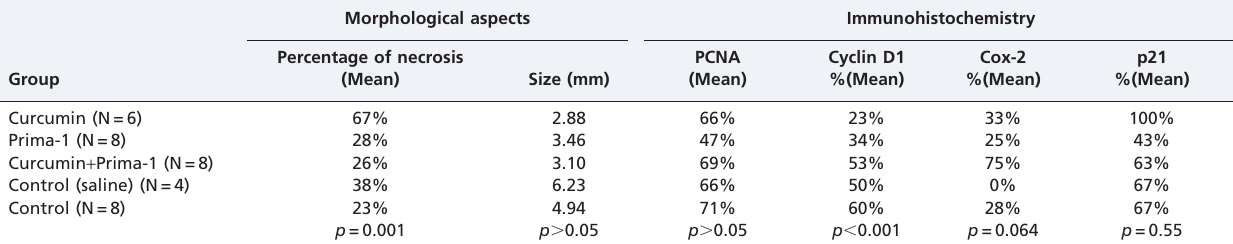
Table 1 - Summary of the findings for the different groups of animals treated with curcumin, Prima-1, or curcumin + Prima-1 and the control